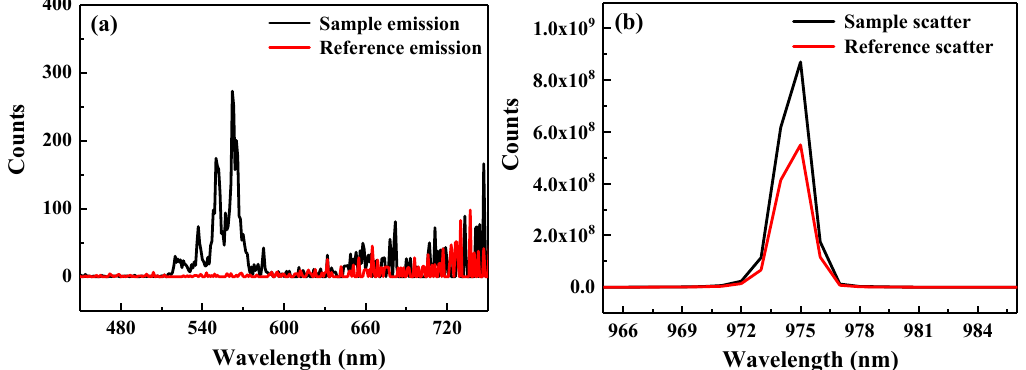
Figure 6. ( a ) The quantum yield (QY) emission spectra of the crystals under 980 nm excitation. ( b ) The QY scatter spectra of the crystals under 980 nm excitation.